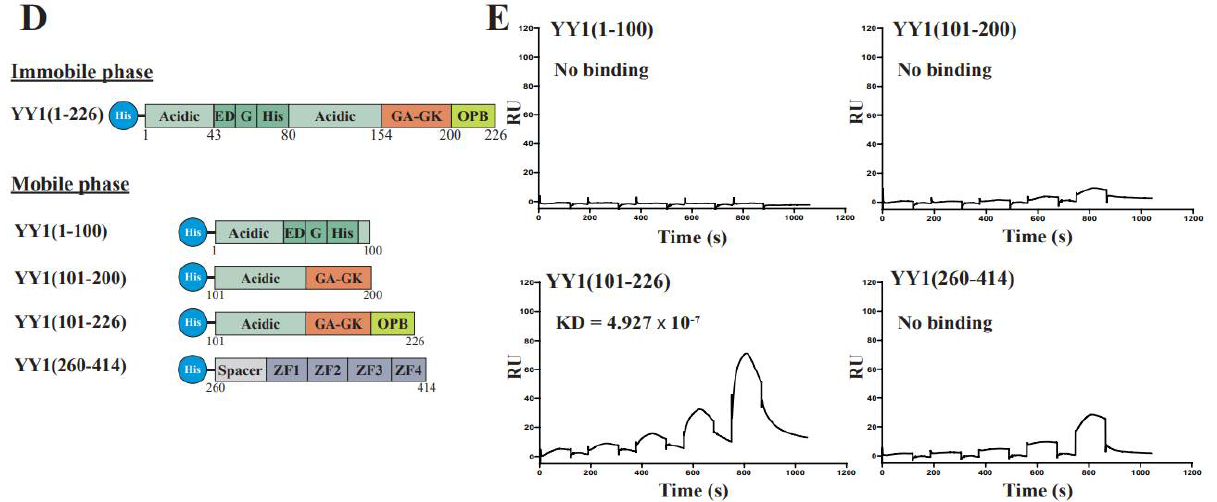
Figure 1. Mapping YY1 binding domains involved in its intermolecular interactions by the surface plasmon resonance (SPR) analysis. ( A ) Schematic diagrams of the domain structures of YY1 protein. “Acidic” represents a region enriched with aspartic and glutamic acids, and “ED” and “G” depict regions containing a glutamic/aspartic acid cluster and a glycine cluster, respectively. “His” indicates a region consisting of 11 consecutive histidines, and “GA” and “GK” represent glycine/alanine- and glycine/lysine-enriched regions, respectively; OPB: oncoprotein binding; the Spacer region and each C2H2-type Zinc finger domain are also denoted. ( B , D ) Diagrams of His-tagged ( × 6) YY1 wt and mutants used to map domains responsible for YY1 intermolecular interactions. ( C , E ) Evaluation of YY1 intermolecular interactions using the SPR analysis. As the immobile phase, purified His × 6-YY1 wt ( C ) and its mutant (1–226) ( E ) were individually conjugated to the CM5 chip (GE healthcare). As the mobile phase, purified His × 6-YY1 wt and its mutant proteins were serially diluted into concentrations of 62.5, 125, 250, 500 and 1000 nM for injection. The samples individually flowed over the chip channels with different conjugates, and the response units (RU) were received from each single cycle. The binding kinetics were analyzed with the Biacore T200 Evaluation software, version 2.0. The results are displayed with time (s) versus and the RU values.